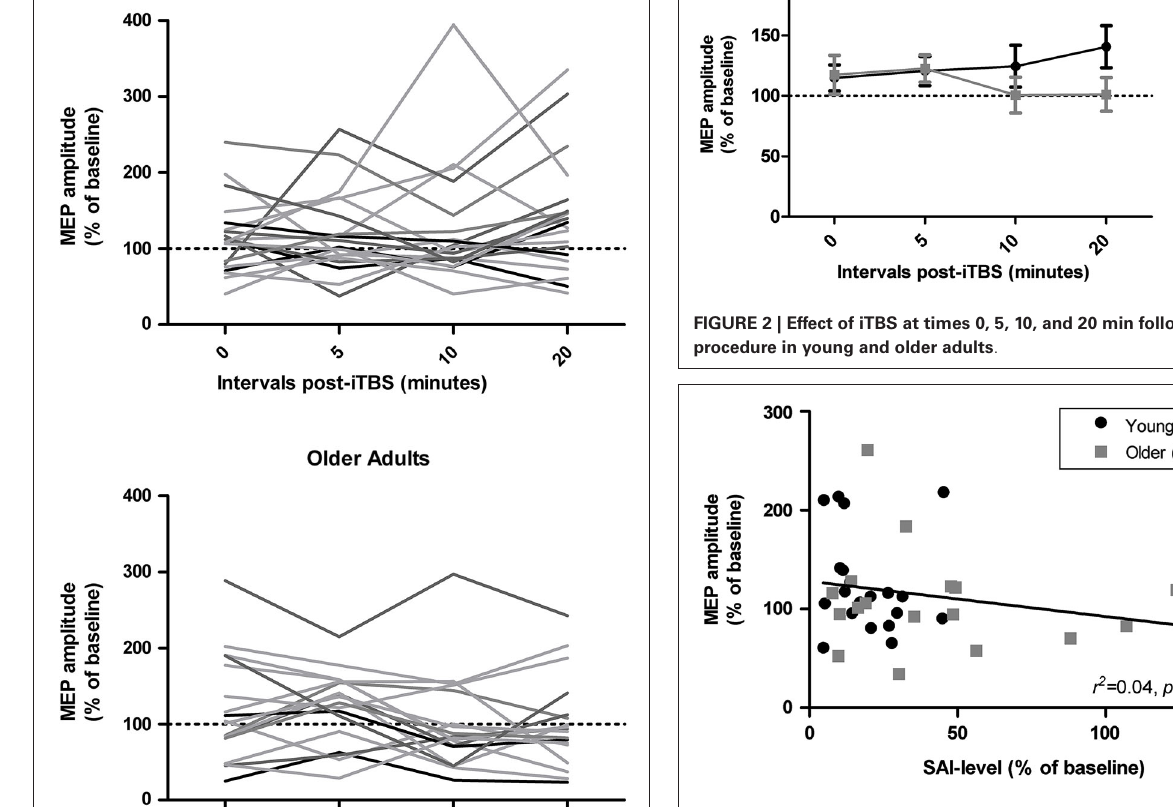
FIGURE 3 | Association between short latency afferent inhibition (SAI) levels and mean modulation of MEP amplitudes (time intervals 0, 5, 10, and 20 min) following iTBS in young and older adults